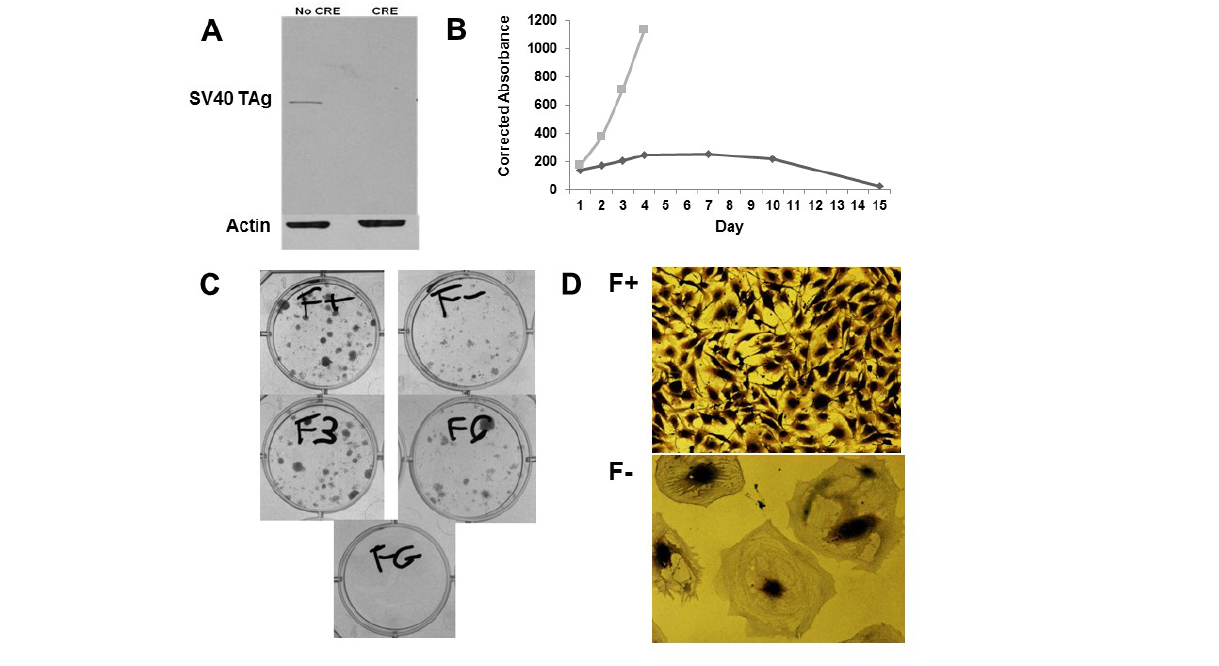
Figure 2. Preliminary data on system characteristics. (A) Repression of TAg expression after CRE-Lox excision of wild-type polyA cassette. (B) Doxycycline-dependent cell proliferation. Gray squares show induction; black diamonds are controls. (C) Doxycycline-dependent clonal cell growth and reanimation. Induced (F+) and not induced (F–) cells are shown. For samples F3 and F6, cells were incubated without doxycycline for 3 or 6 days, respectively, and then doxycycline was added to the media. (D) Typical cellular phenotypes from samples F+ (with doxycycline) and F– (no doxycycline) are